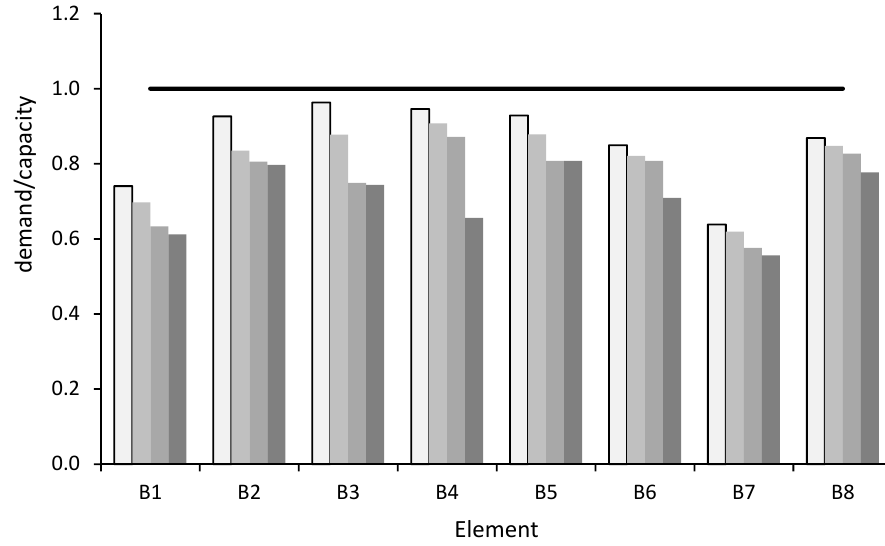
Figure 21. Bending verifications of beams after retrofit.